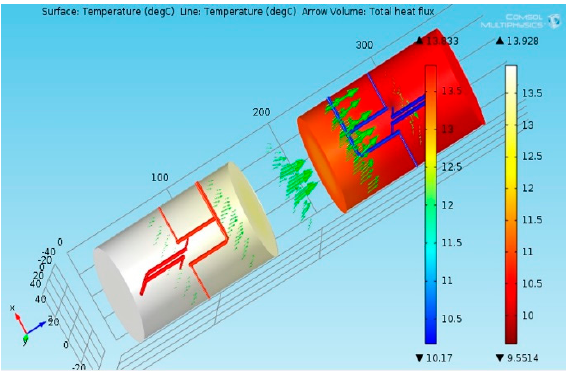
Figure 12. An example of simulation results for a rotating frequency of 17 Hz (that corresponds to 1000 rpm) and for a hot source temperature T H of 22 °C. rpm) and for a hot source temperature T H of 22 ◦ C.